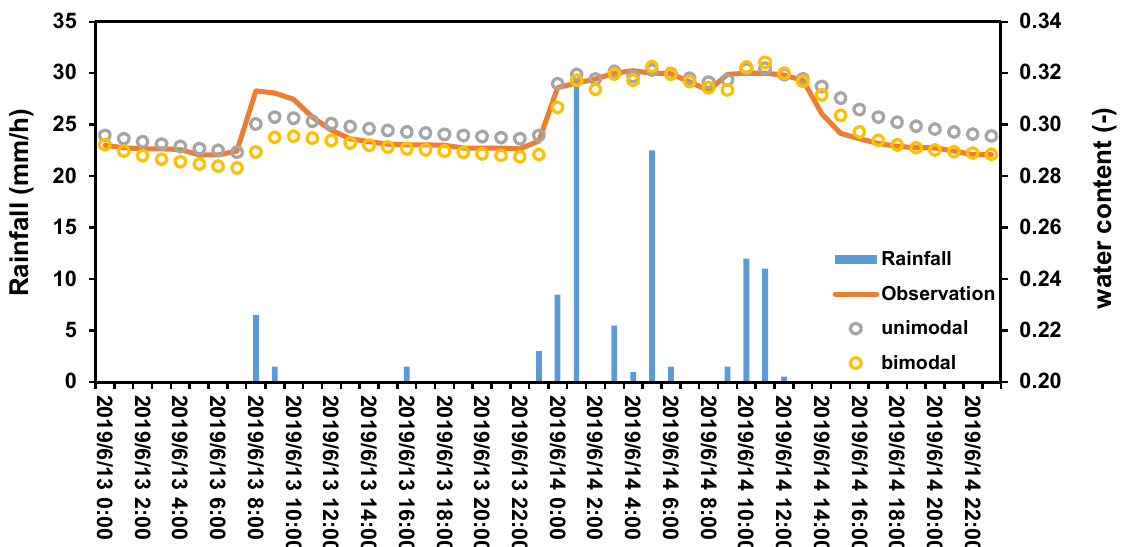
Figure 5. Rainfall events and calibration results of the field soil water content.